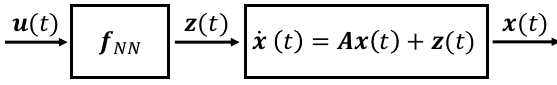
Figure 3. Nonlinear continuous time system of the Hammerstein Model.